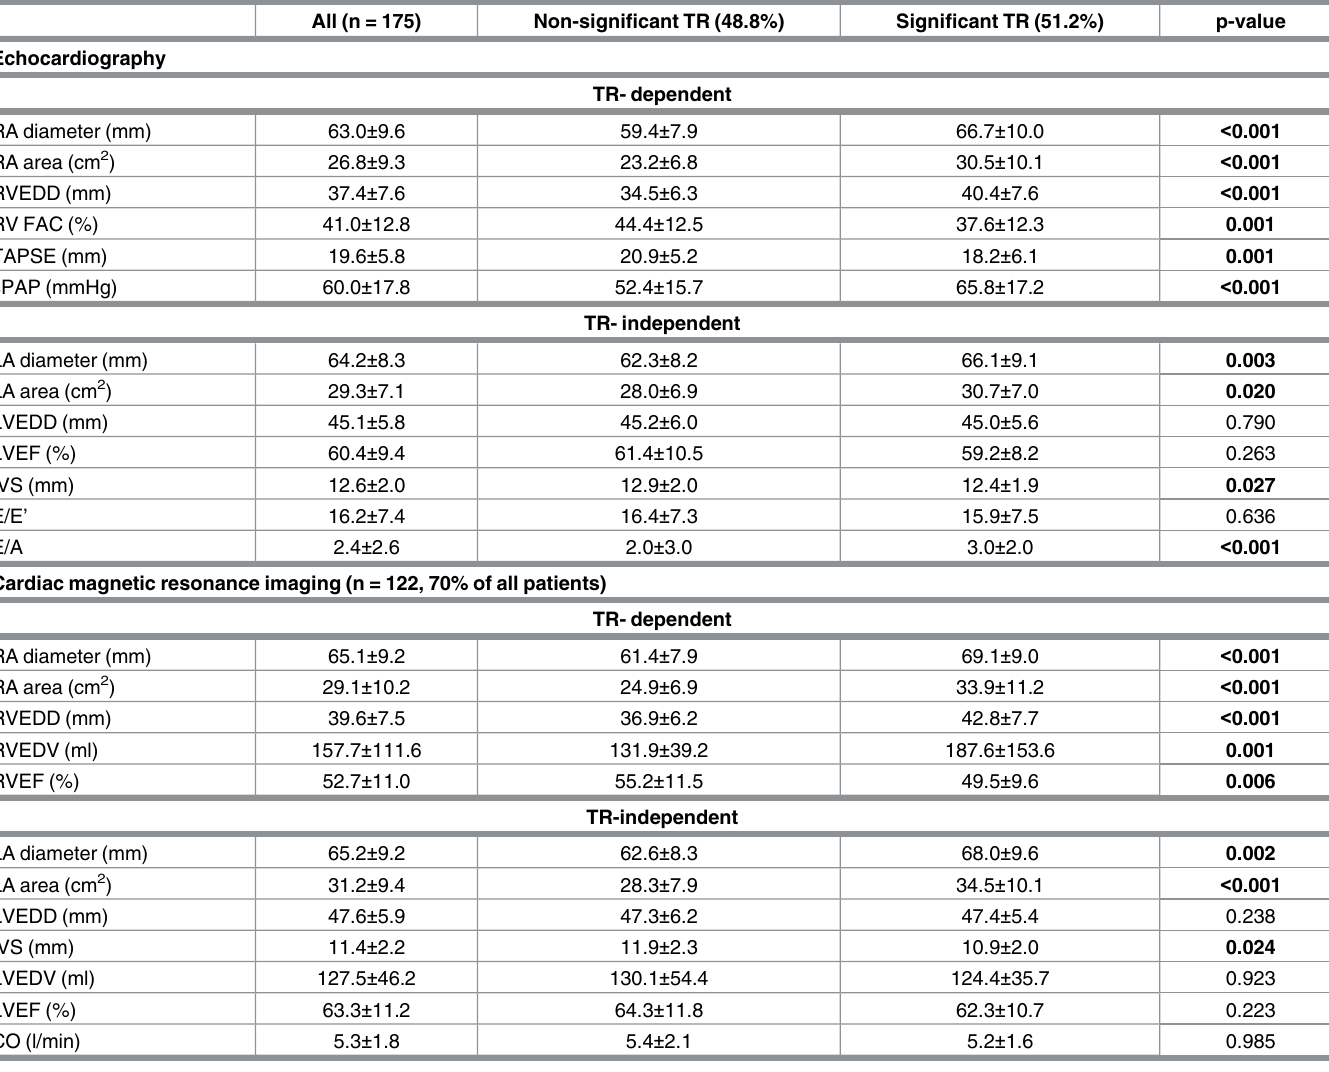
Table 5. Baseline imaging characteristics in HFpEF patients, stratified by tricuspid regurgitation severity. All (n = 175)